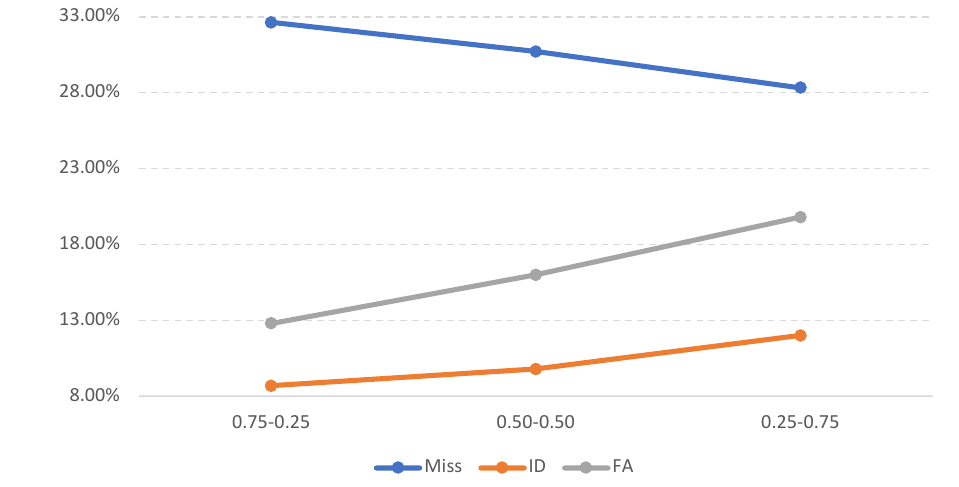
Figure 5. Evolution of the different types of errors (MISS, FA, ID) for each different γ , β parameter configuration.